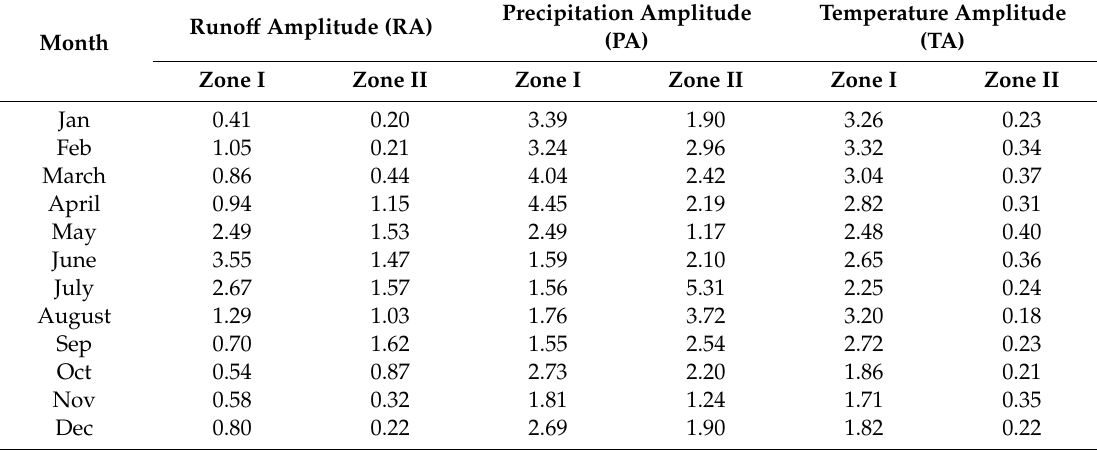
Table 4. Comparison of the amplitudes of various parameters in Zones I and II.